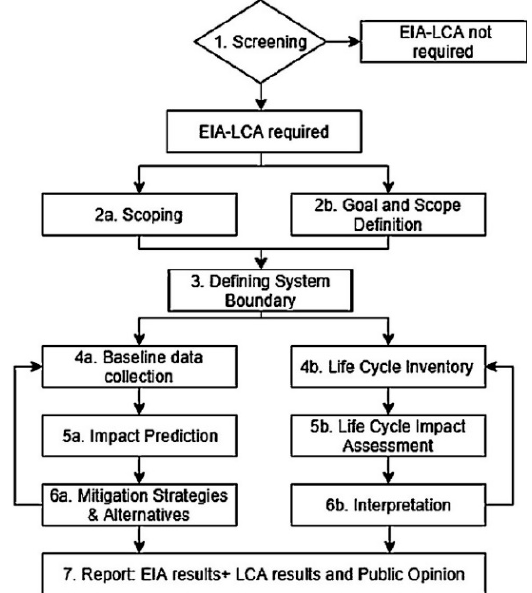
Figure 1. General framework for integrating the life cycle assessment (LCA) (right-side boxes, labeled “ b ”) into the process of the environmental impact assessment (EIA) (steps 1–7, including left-side boxes labeled “ a ”) based on the procedural overlap between the tools. The steps 2b and 4b–6b correspond to the LCA methodology, as defined in ISO standard 14040 and